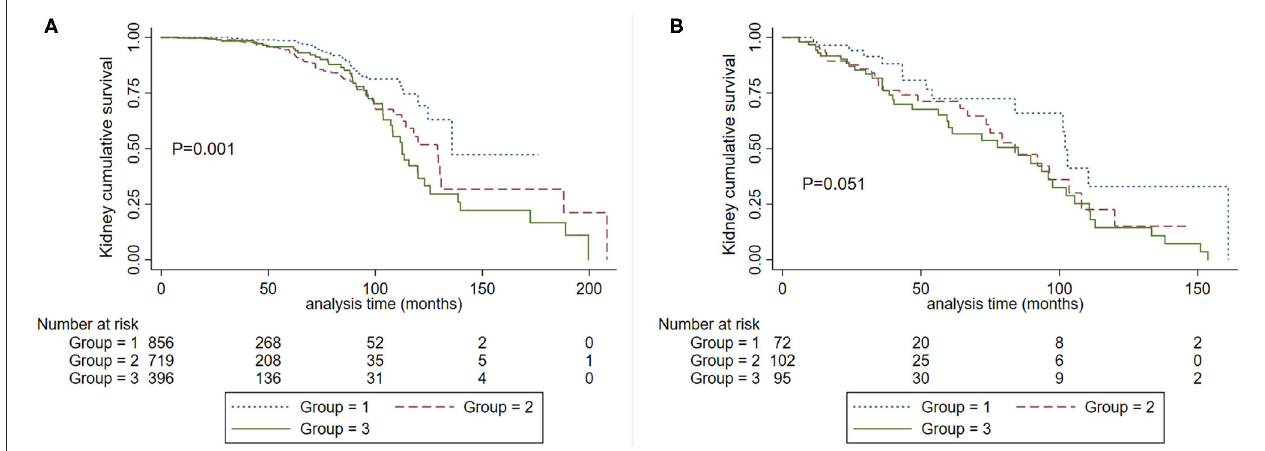
FIGURE 4 | Kaplan-Meier renal survival curves according to SBP levels in patients with CKD 1-3a stage (A) and CKD 3b-4 stage (B) . Group 1. Systolic blood pressure < 120mm Hg. Group 2, systolic blood pressure < 140mm Hg and ≥ 120mm Hg. Group 3. Systolic blood pressure ≥ 140mm Hg.